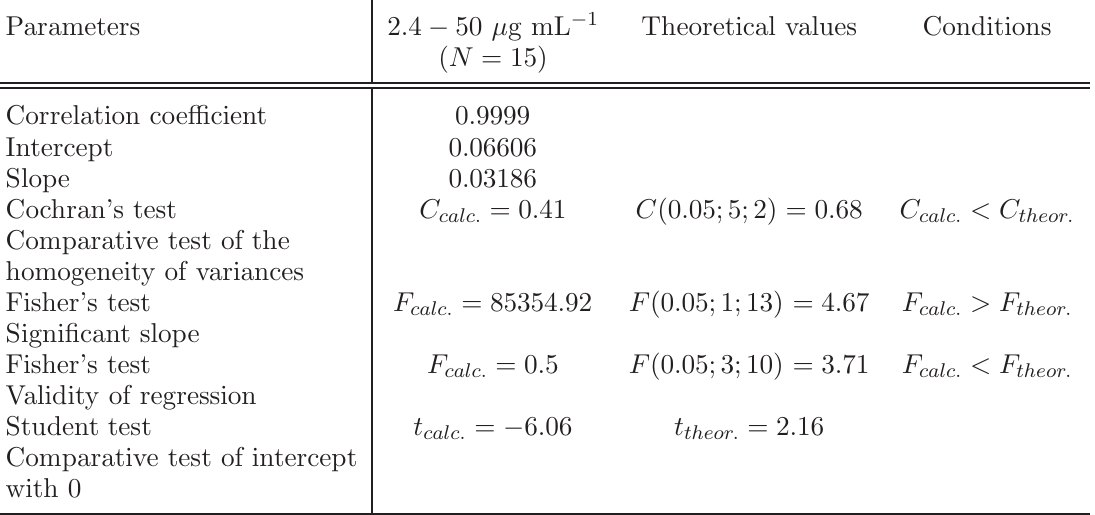
Table 2 Linear regression data ( n = 5).